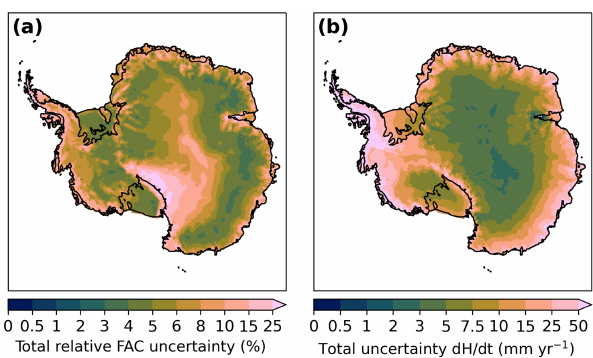
Figure 10. Maps from FDM v1.2A of the estimated ice-sheet-wide total uncertainty in (a) firn air content (FAC) and (b) surface eleva- tion change (d H/ d t ) from the sensitivity analysis. The FAC uncer- tainty for all experiments and surface elevation change uncertainty for the spin-up experiments are calculated over 1979–2020, and the surface elevation change uncertainty for the MO fits, ρ s , T s and ˙ b experiments are calculated over